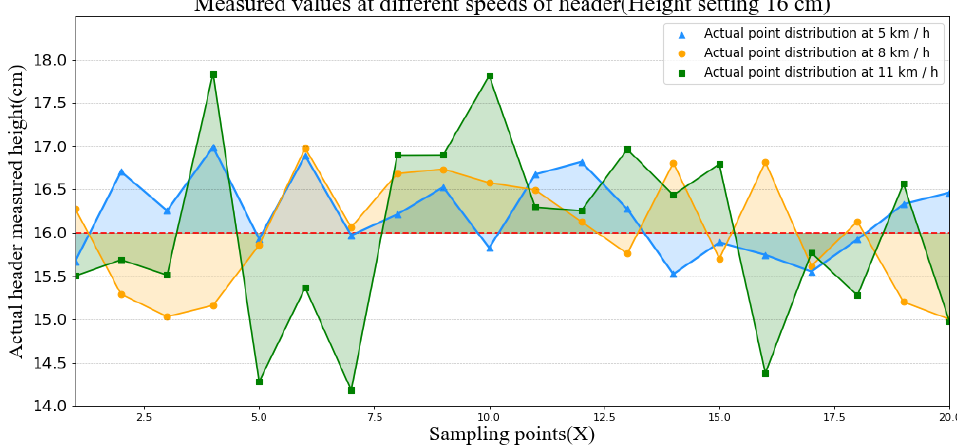
Figure 24. Comparison of different speeds when cutting stubble at 16